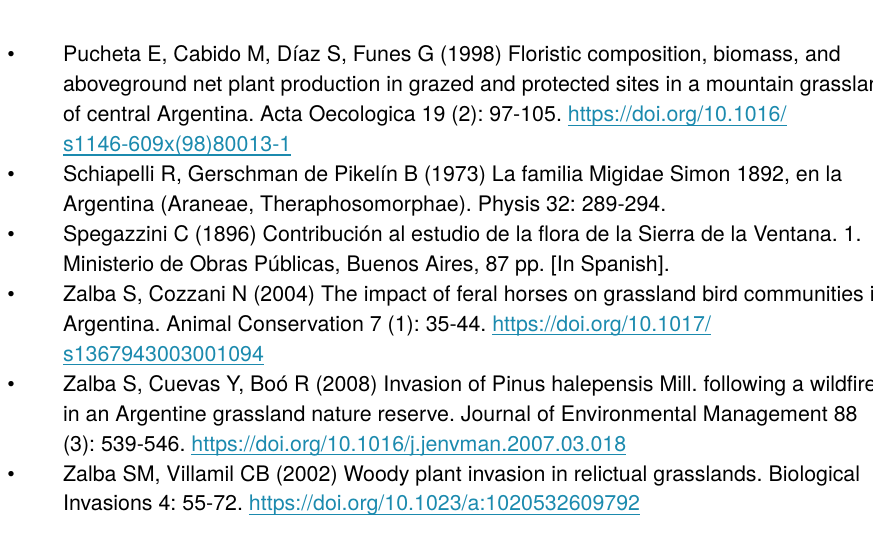
Suppl. material 1: Range